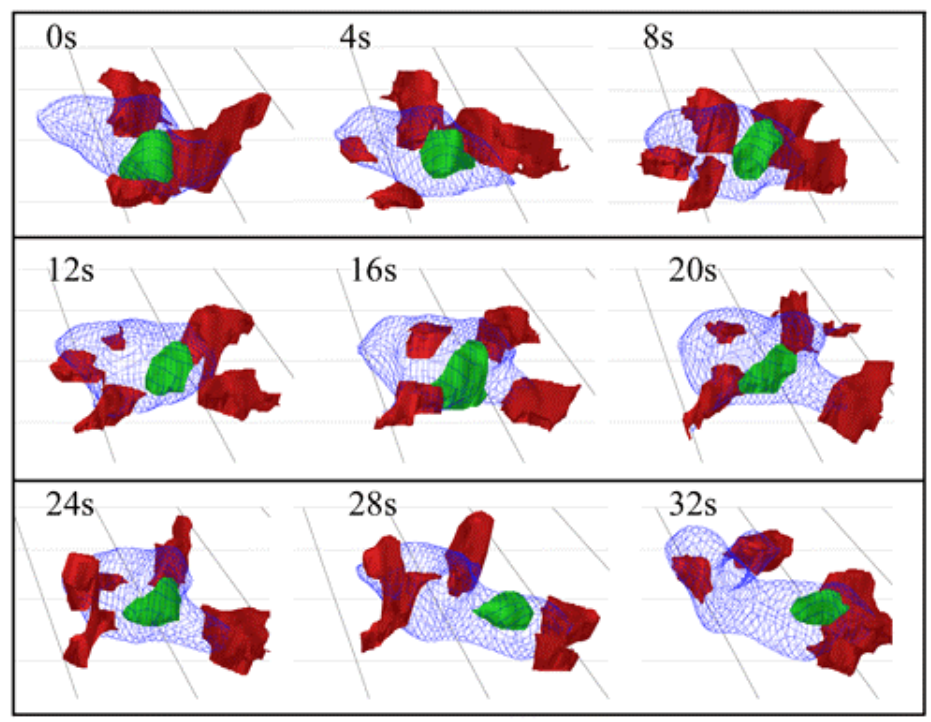
FIGURE 6. 3D-DIAS reconstructions of a myoA - mutant Dictyostelium amoeba crawling in a spatial gradient of cAMP. Note multiple pseudopods, pseudopod placement, and loss of polarity. See legend to Fig. 2 for details of reconstructions.